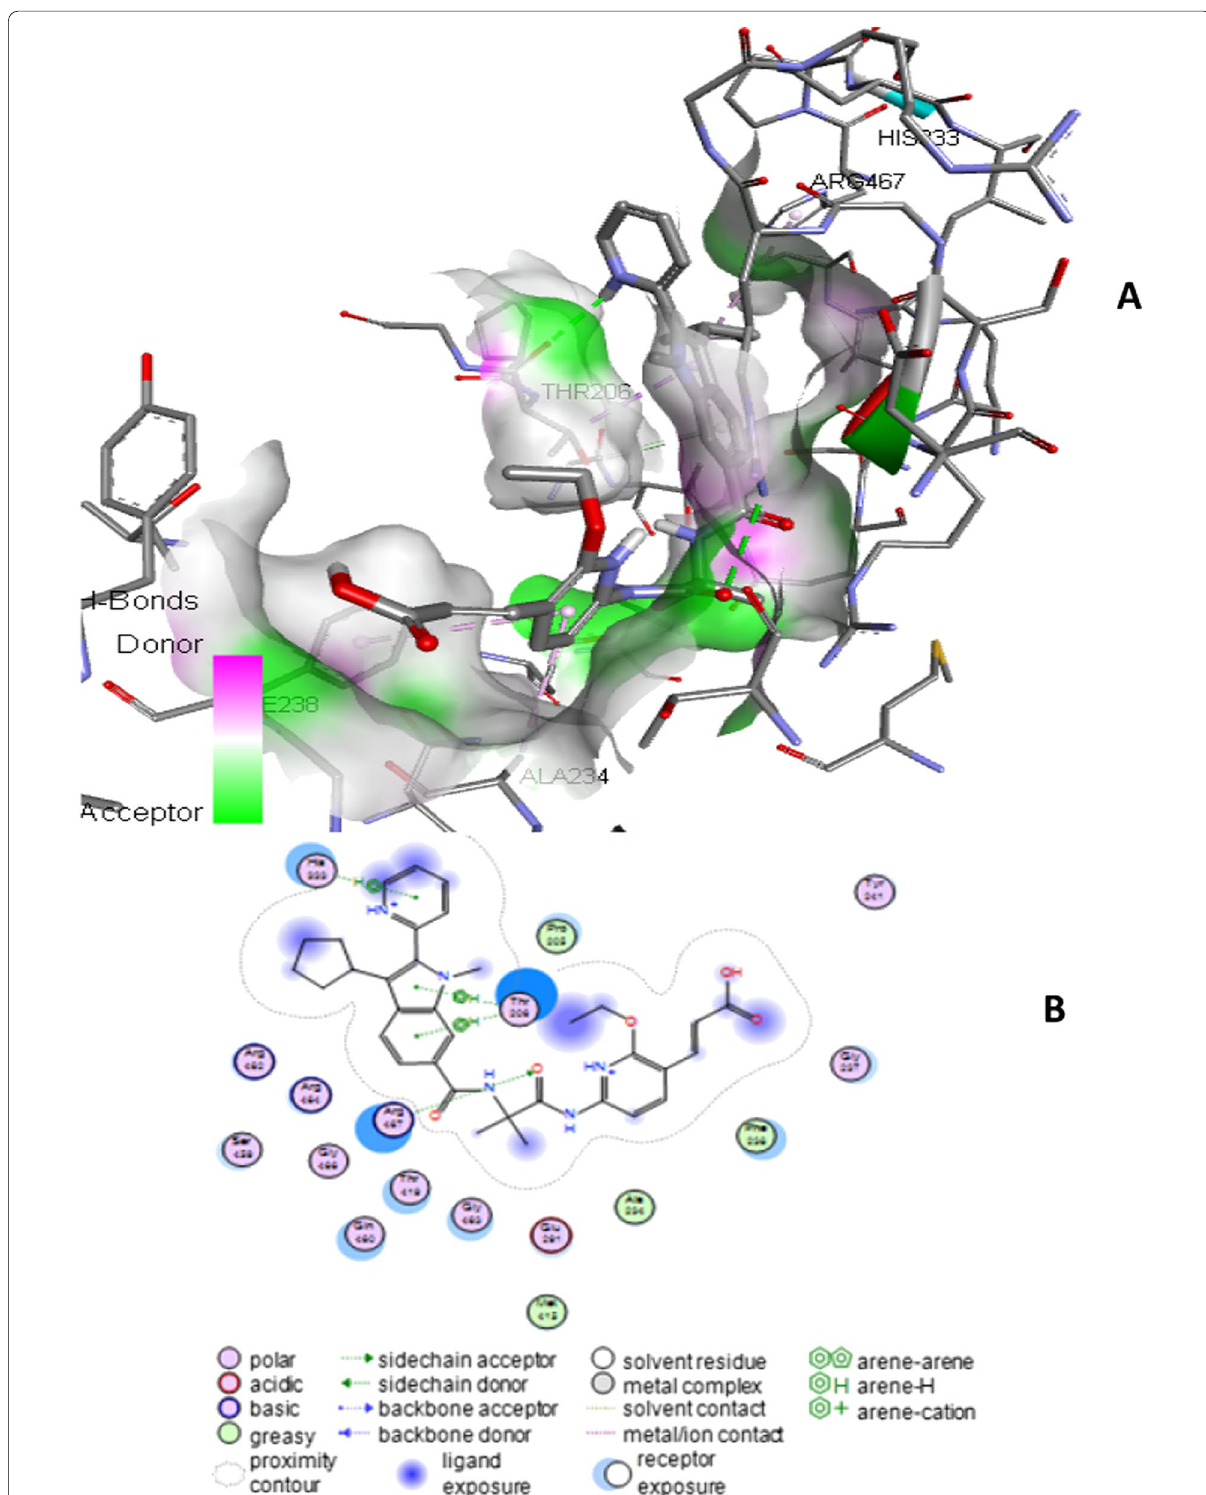
Fig. 7 A 3D diagram for the interaction of template molecule T in complex with the target receptor (hepatitis C virus NS5B RNA polymerase, PDB ID: 4MKA), B 2D diagram for the interaction of template molecule T in complex with the target receptor (hepatitis C virus NS5B RNA